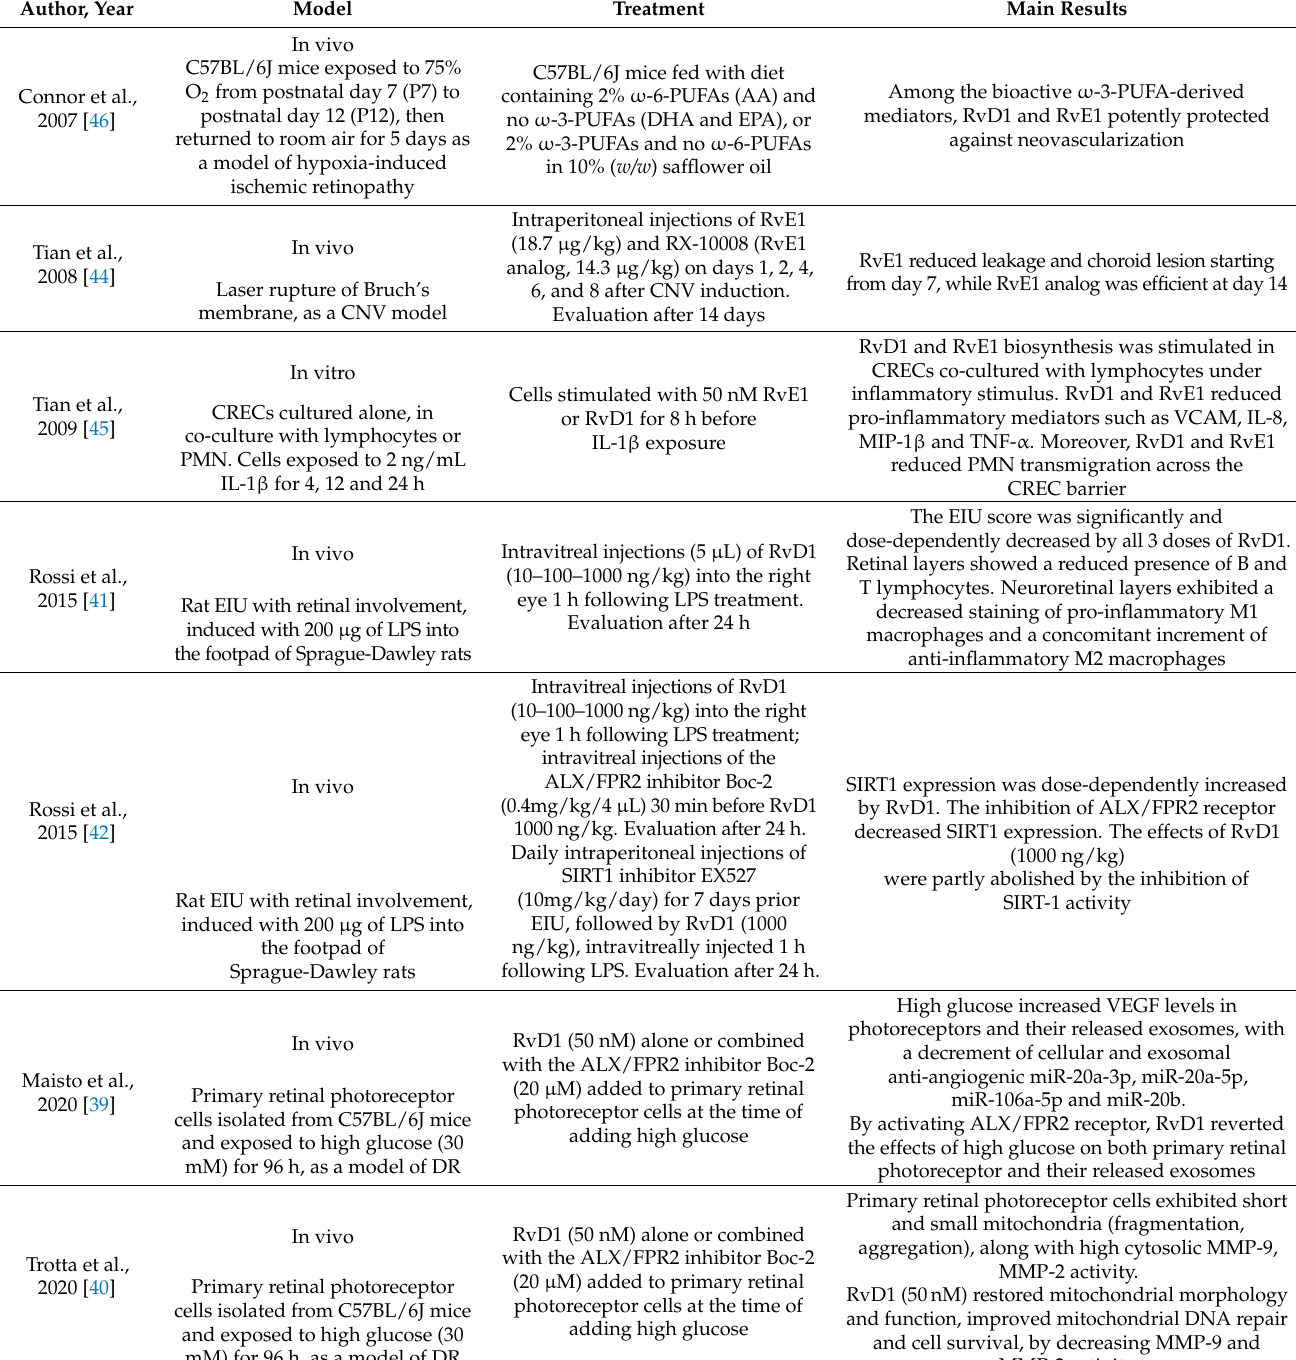
Table 2. Resolvins and retinal